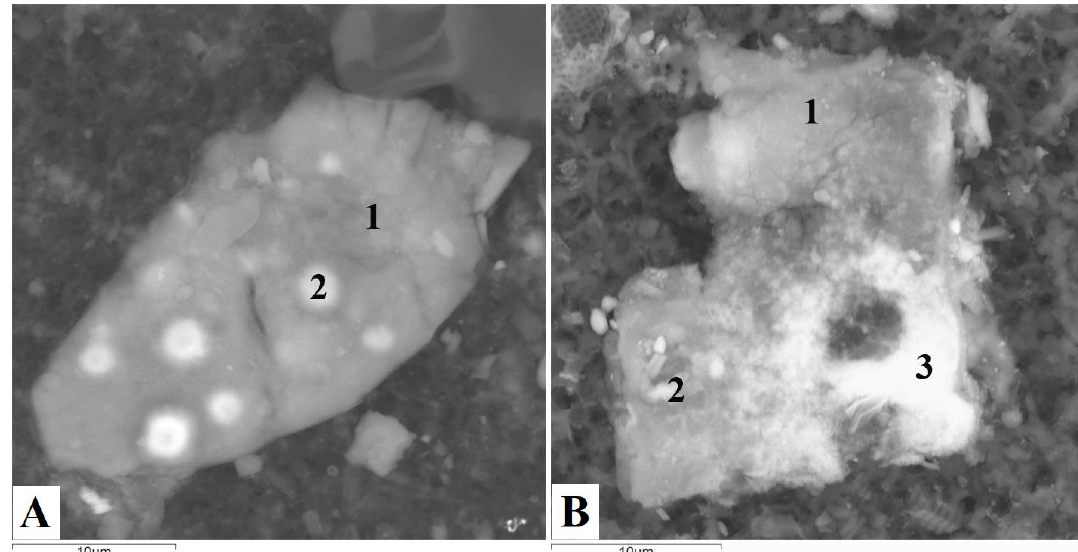
Figure 5. Micrographs made using SEM of samples of river suspended matter on filters taken in the Shuya ( A ), Vodla (B) and Sheltozerka ( C ) rivers: ( A ) 1 — shells and biodetrite of diatoms, 2 — muscovite, 3 — quartz and 4 — K-feldspar; ( B ) 1 — shells and biodetrite of diatoms, 2 — Fe-Mn oxides and hydroxides, 3 — plagioclase (10 – 30% anorthite) and 4 — quartz; ( C ) 1 — quartz, 2 — K-feldspar, 3 — epidote, 4 — shells and biodetrite of diatoms and 5 — Mg-Fe illite.